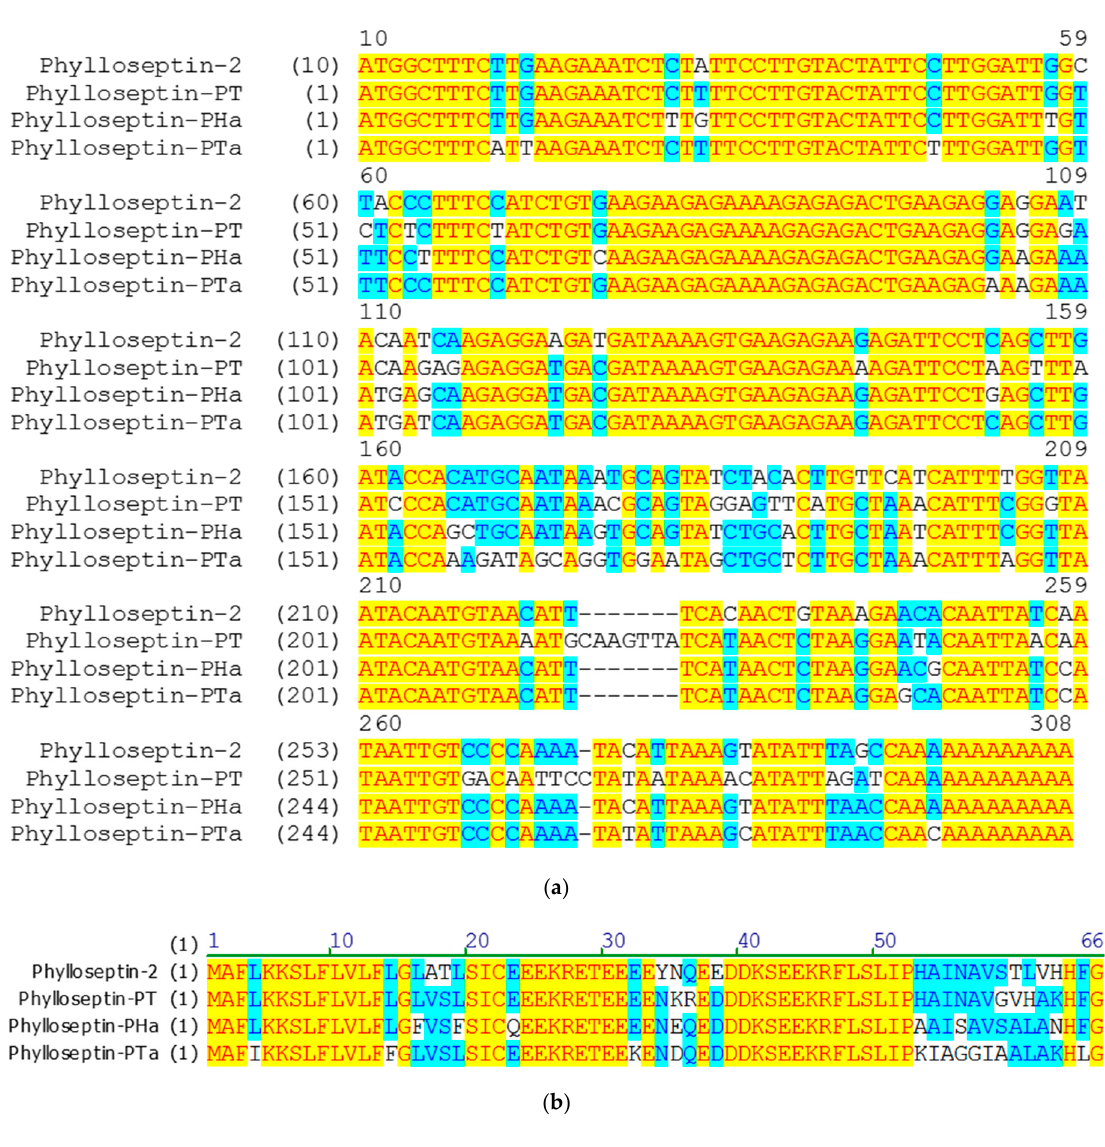
Figure 2. Alignments of ( a ) nucleotides and ( b ) translated open-reading frame amino acids sequences of biosynthetic precursors of phylloseptin-PTa, phylloseptin-PHa, phylloseptin-2 and phylloseptin-PT established by the Vector NTI Advance 11.5.1 package. The identical and conservative regions are highlighted in yellow and blue, respectively.